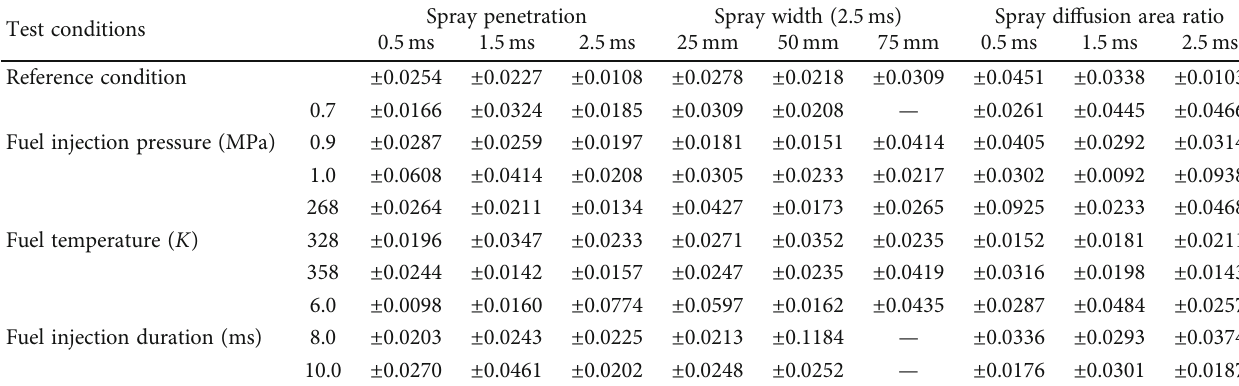
Table 6: Uncertainty analysis of experimental